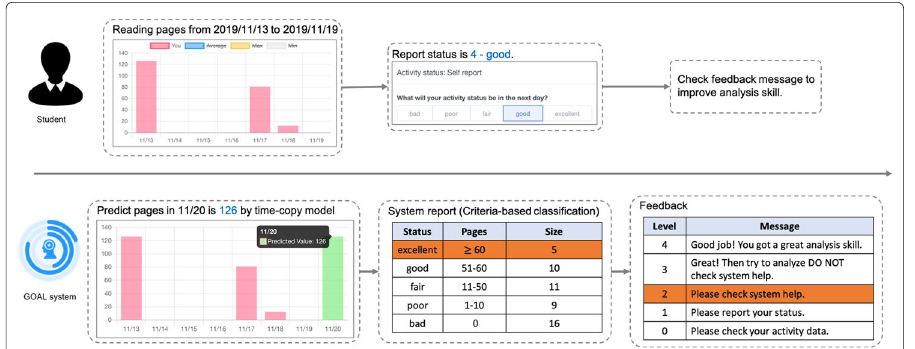
Fig. 4 Example of supporting analysis skill in learning